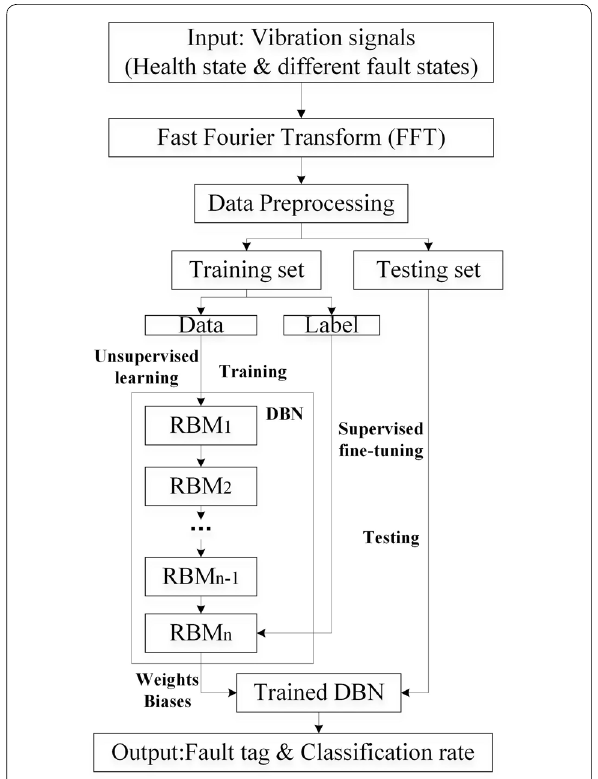
Figure 17 Deep learning method based on